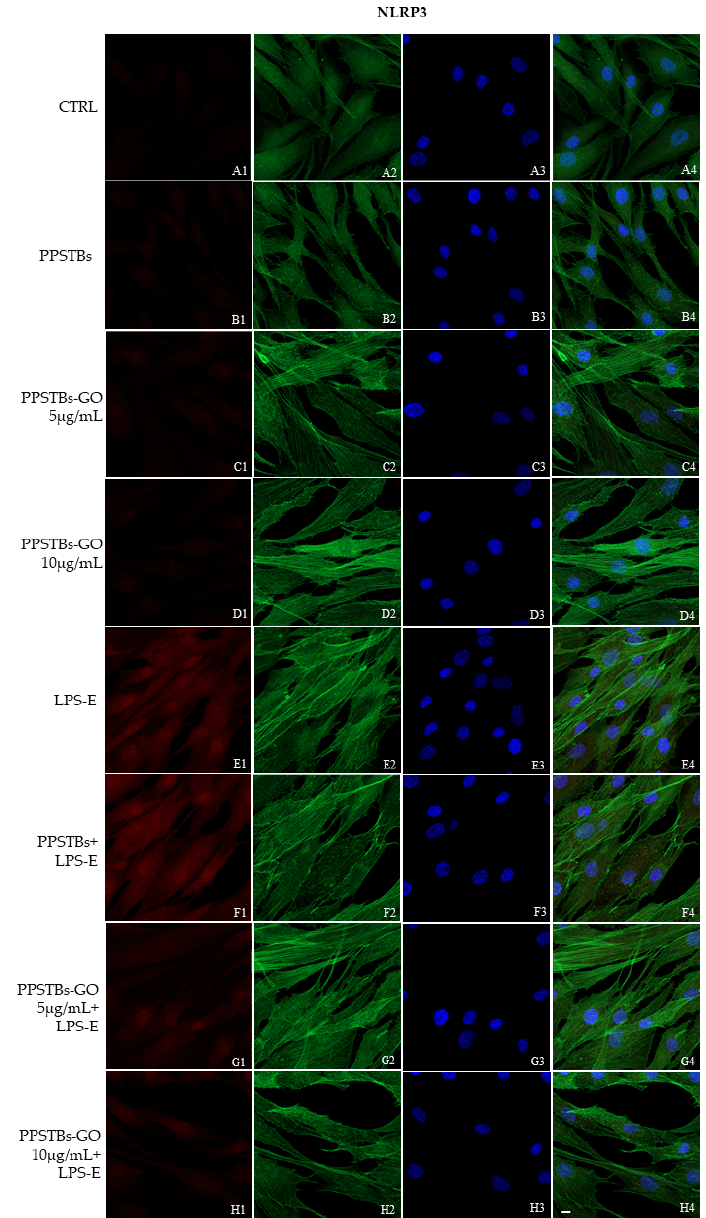
Figure 8. NLRP3 signaling pathway in hGFs cell line. Expression of NLR3 analyzed by confocal microscopy ( A1 – H4 ), NLRP3 expression untreated cells (CTRL), in hGFs cultured with PPSTBs, in hGFs cultured with PPSTBs enriched with GO at 5 μ g/mL, in hGFs cultured with PPSTBs enriched with GO at 10 μ g/mL, in hGFs stimulated with LPS ‐ E, in hGFs cultured with PPSTBs and stimulated with LPS ‐ E, in hGFs cultured with PPSTBs enriched with GO at 5 μ g/mL and stimulated with LPS ‐ E and in hGFs cultured with PPSTBs enriched with GO at 10 μ g/mL and stimulated with LPS ‐ E. Red fluorescence: Red fluorescence: NLRP3 ( A1 – H1 ); Green fluorescence: cytoskeleton actin ( A2 – H2 ); Blue fluorescence: cell nuclei ( A3 – H3 ) and Merge ( A4 – H4 ). Scale bar: 20 μ m.